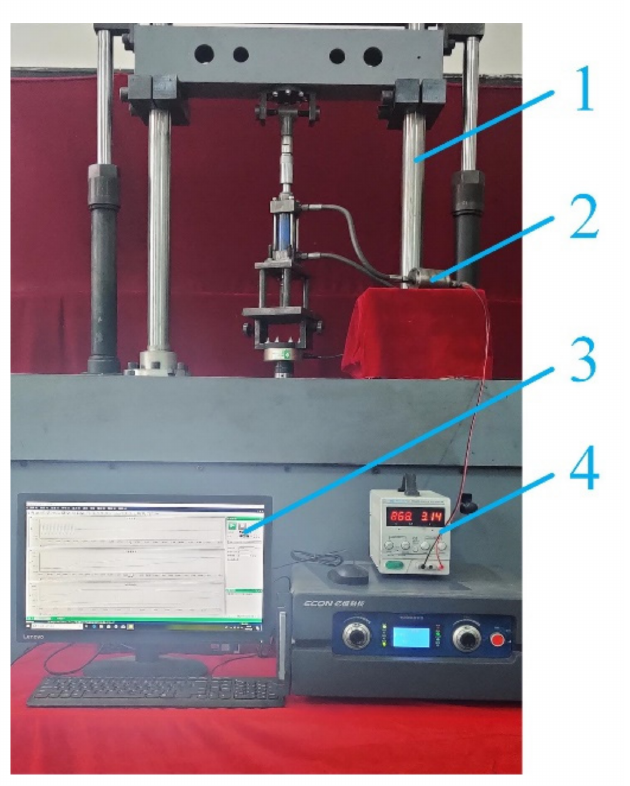
Figure 16. Experimental test rig of the proposed MR valve controlled cylinder system: 1. Damper test system; 2. Annular-radial-orifice flow MR valve controlled cylinder system; 3. Host computer; 4.DC power